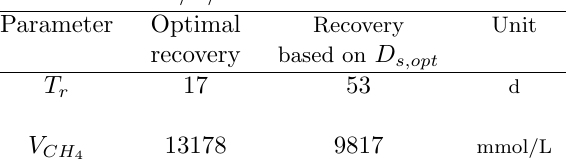
Table 4: Comparison regarding the recovery time and the volume of the produced methane over 100 days between two methane recovery proce- dures with respect to the CH 4 threshold = 15 mmol/L/d.